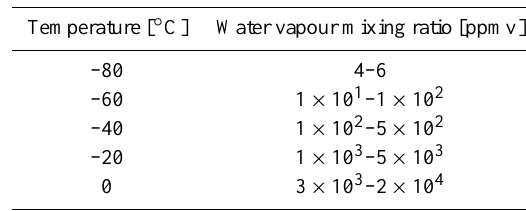
Table 7. Approximate water vapour mixing ratios at the temperature level shown in Fig. 18.